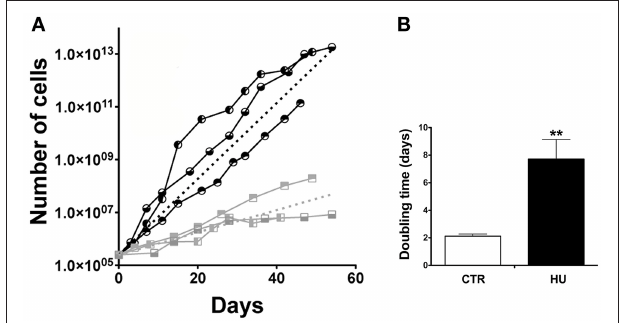
FIGURE 2 | Growth curve and doubling time. (A) Proliferation capabilities comparison between CTR and HU samples. Each node of the curve represents a passage. The analysis was performed for 60 days of growth. CTR1; CTR2, CTR3; HU1; HU2; HU3. Dashed lines represent the average of CTR (black) and HU (gray). The average curves were built as the average of the slope of the CTR curves and HU curves with the constraint that the curve has value 250,000 at day 0. (B) Doubling time of proliferation expressed in days was calculated as the average of the doubling time of the single samples by means of non-linear fit regression. Black CTR, Gray HU. ** p <